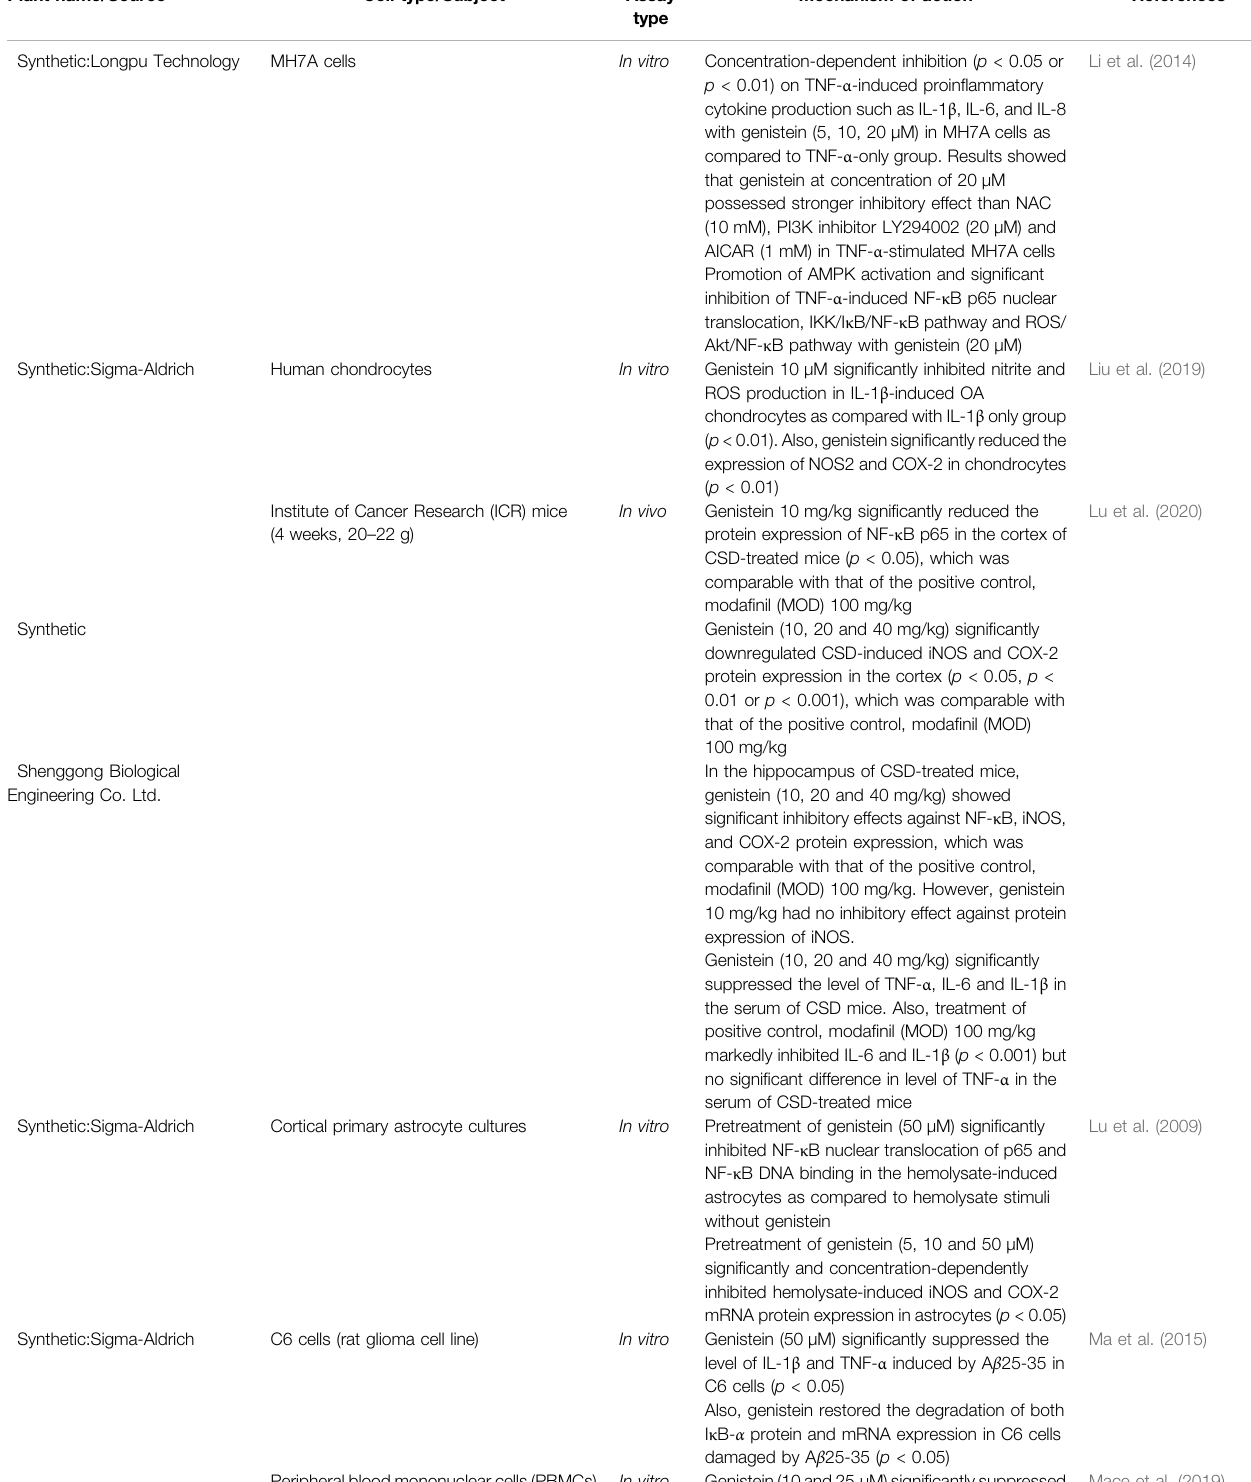
TABLE 1 | ( Continued ) Genistein with potent anti-in fl ammatory